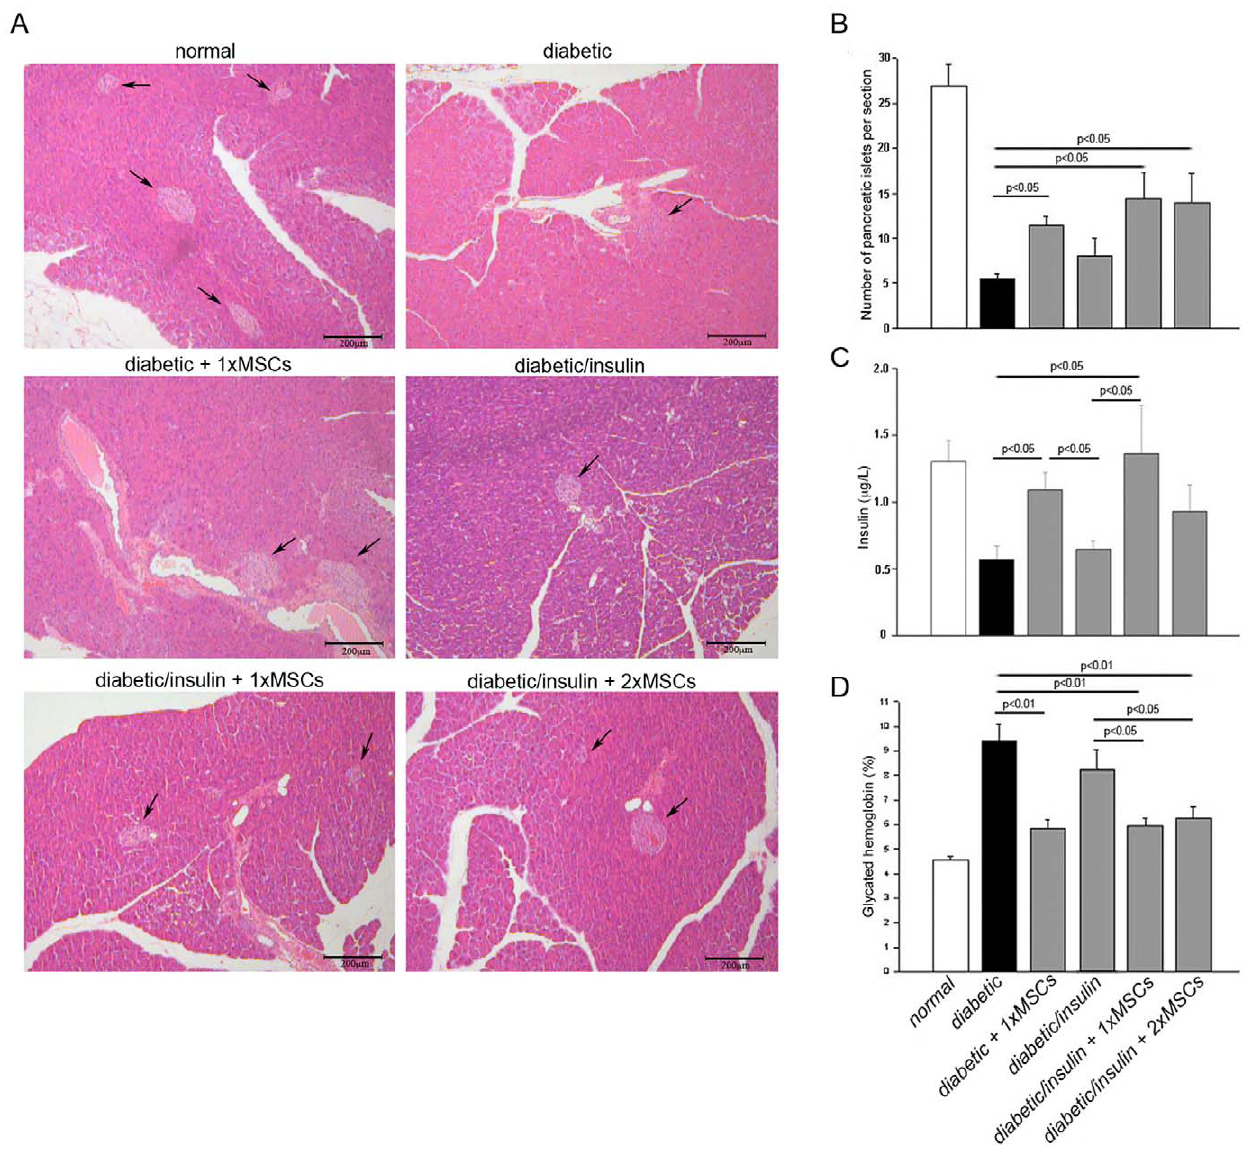
Figure 3. Pancreatic islets recovery, insulin secretion improvement and glycated hemoglobin normalization in diabetic mice after MSC transplantation. At day 130 after diabetes induction, pancreatic islets were observed (A) and quantified (B) in serial 4 m m hematoxilin/eosin– stained sections; mouse insulin levels were determined in venous blood samples obtained from alert fasted mice (C); glycated hemoglobin levels were determined in venous blood samples obtained from alert fasted mice (D). Qualitative data are representative from 4 animals per experimental group. Quantitative data correspond to mean 6 s.e.m. from 9 animals per experimental group. Only statistical significant values among diabetic mice are shown.